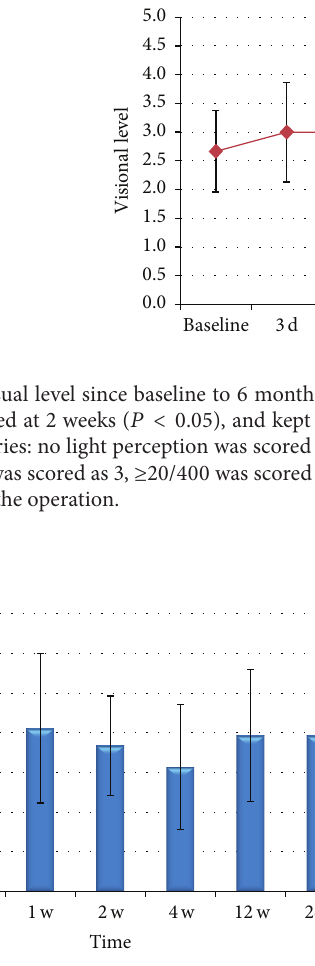
Figure5:ChangesofIOPsincebaselineto6monthsafteroperation. The GEE analysis showed that average IOP fluctuated from 15.69 to 19.62 mmHg, and the changes were not significant during the 6- month study ( 𝑃 > 0.05